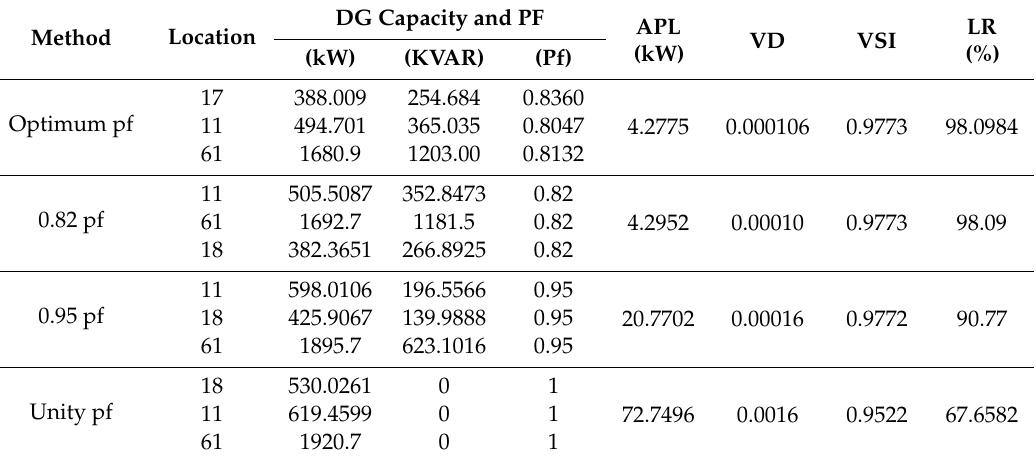
Table 10. Comparing results for di ff erent power